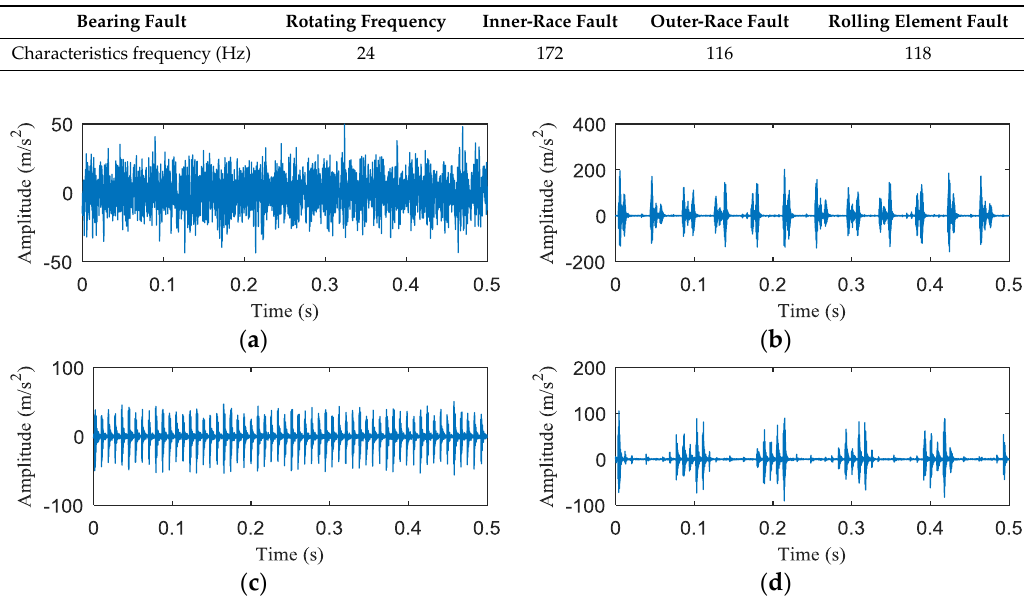
Table 5. The defect frequencies of cylindrical roller bearing at 1440 rpm.